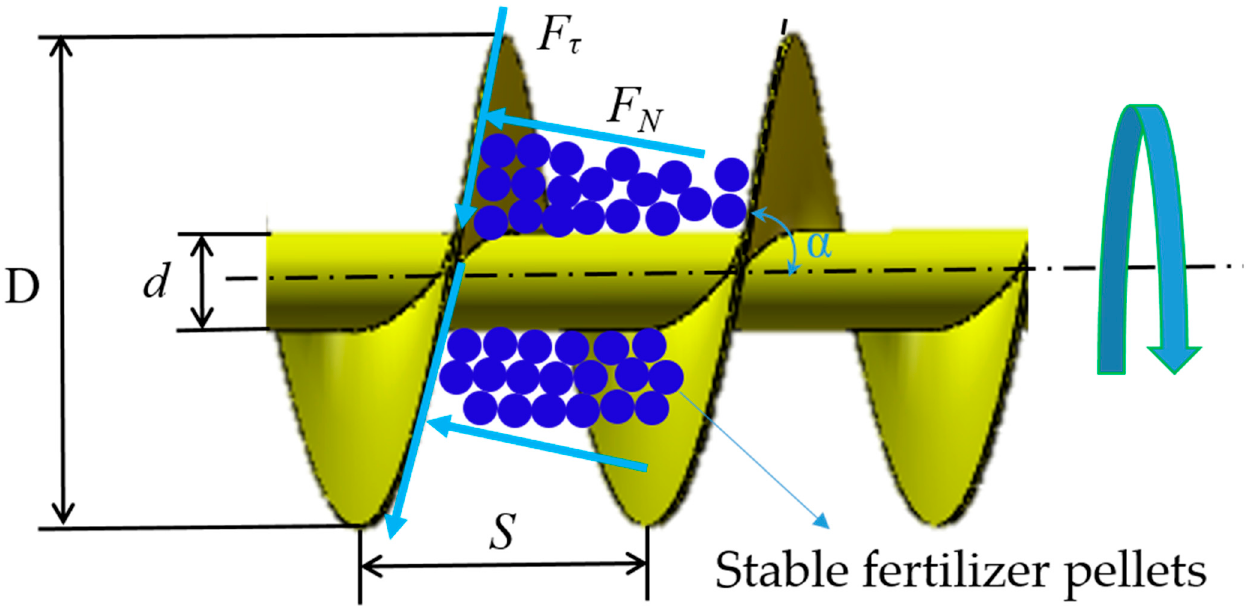
Figure 4. Schematic diagram of the combined fertilization device structure. D is the outer diameter of the spiral blade (mm), d is the diameter of the central axis (mm), F τ is the tangential friction force on the blade (N), F N is the normal pressure on the blade (N), S is the pitch (mm).